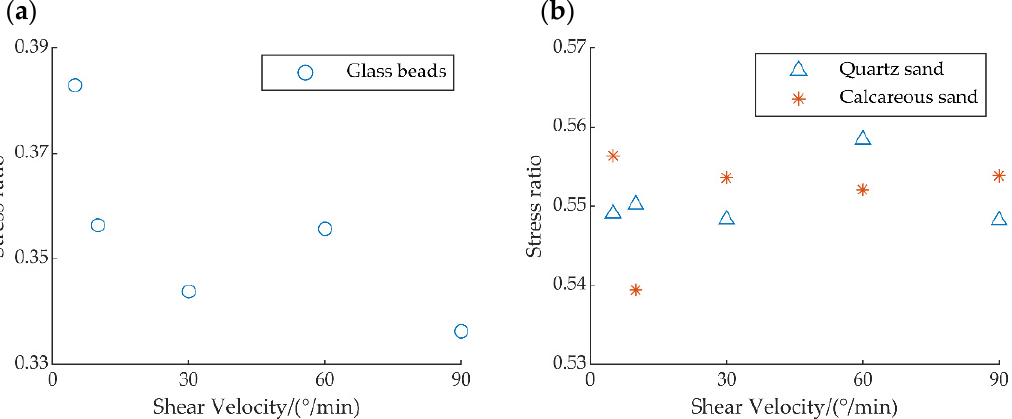
Figure 8. Relationship between the shear rate and stress ratio for the different particle systems: ( a ) glass beads, ( b ) quartz sand and calcareous sand.